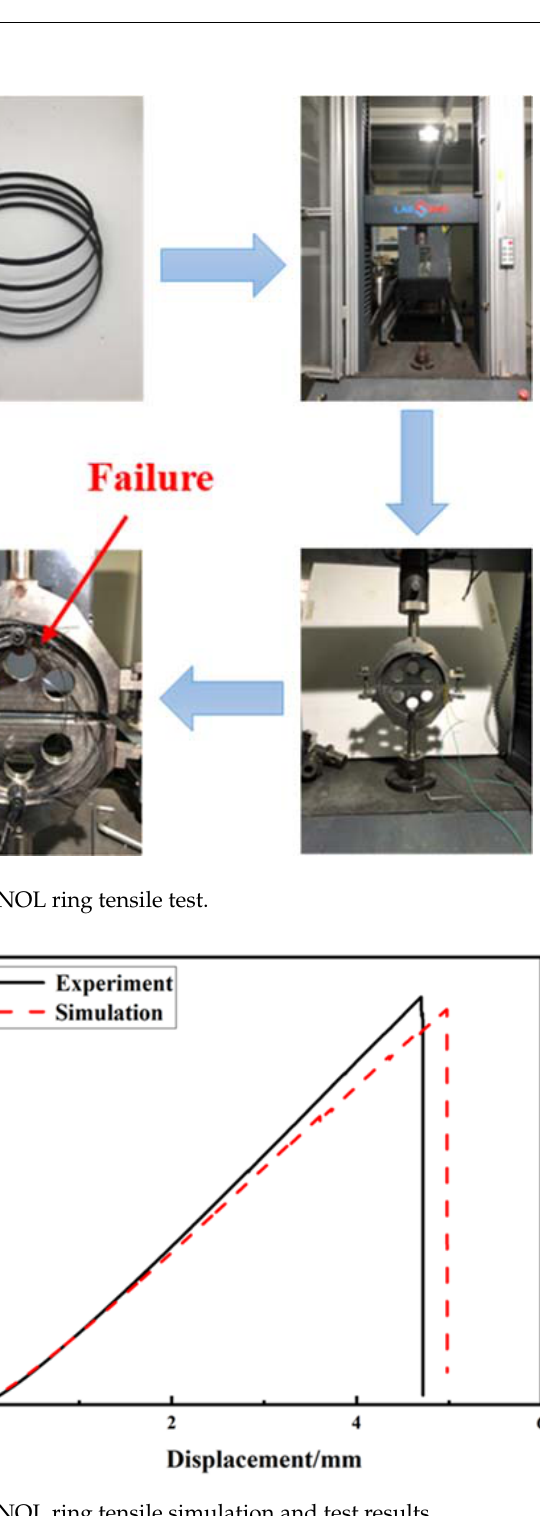
Figure 6. NOL ring tensile simulation and test results.